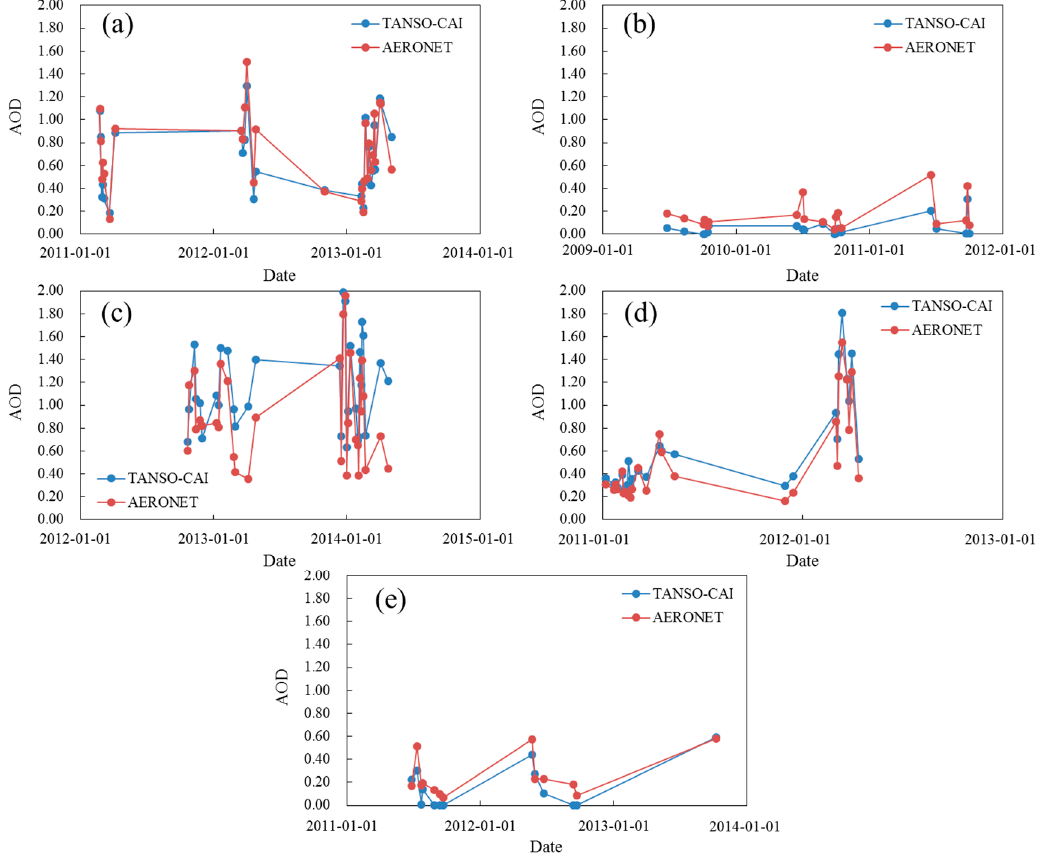
Figure 10. Variation curve of AODs from the spatially and temporally collocated TANSO-CAI and Aerosol Robotic Network (AERONET) data; ( a ) Vientiane site; ( b ) Xinglong site; ( c ) Dhaka_University site; ( d ) Chiang_Mai_Met_Sta site; and ( e ) Ussuriysk site.